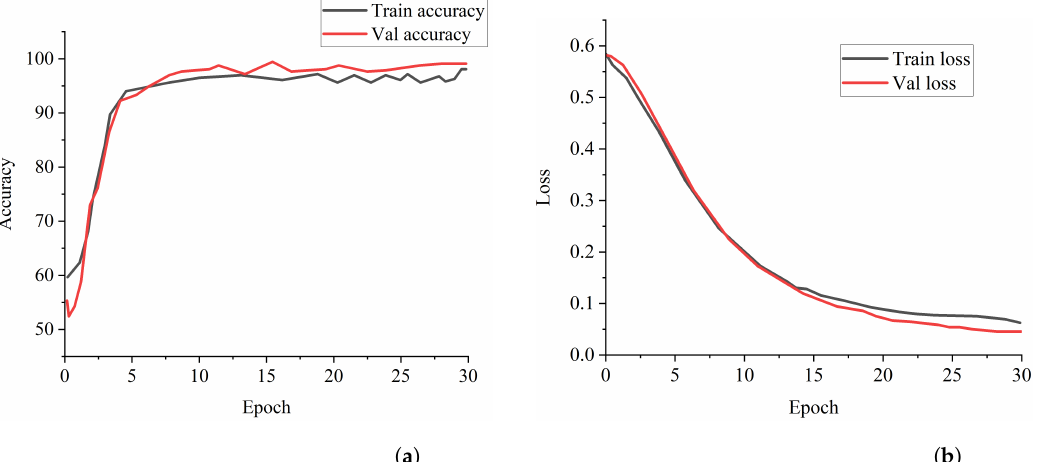
Figure 4. Training and validation curves for the proposed model. ( a ) Accuracy curve showing the performance of our proposed NW-CapsNet model. ( b ) The loss curve of our proposed NW-CapsNet model showing the stability of our model.